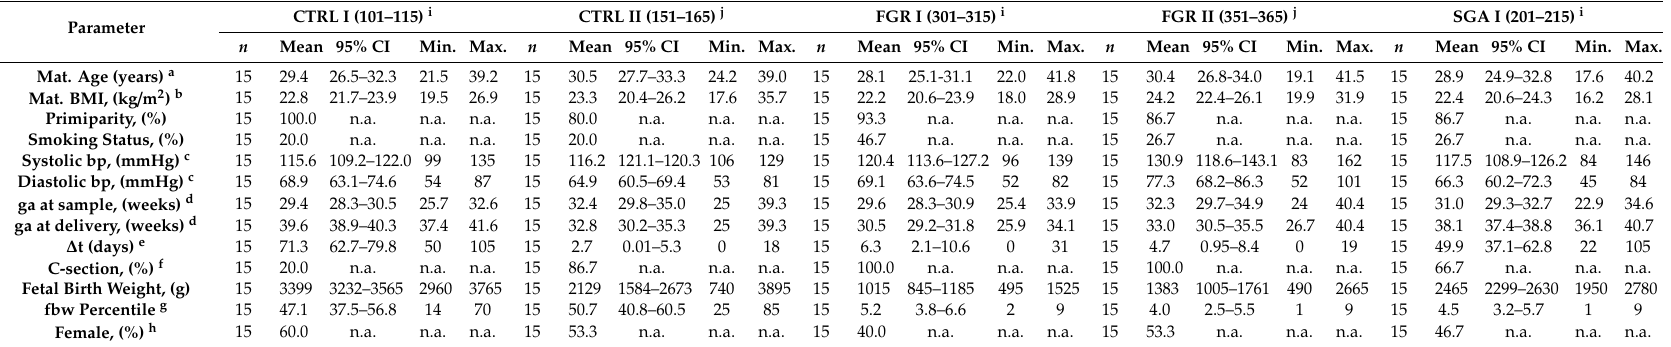
Table 1. Summarized or averaged demographic data as well as clinical and laboratory parameters for all patients and control